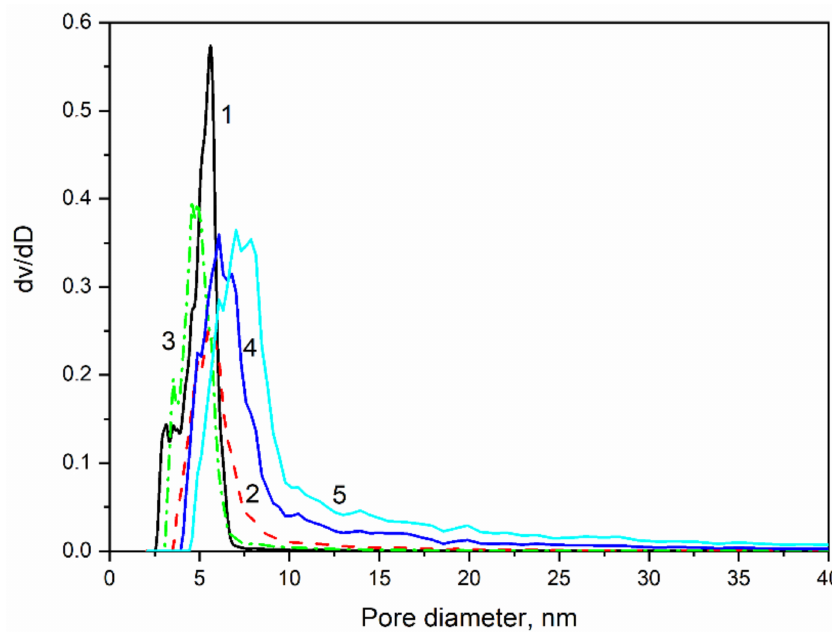
Figure 5. Pore size distribution of silica samples with different degrees of hydrophobicity: 1—MJ0,